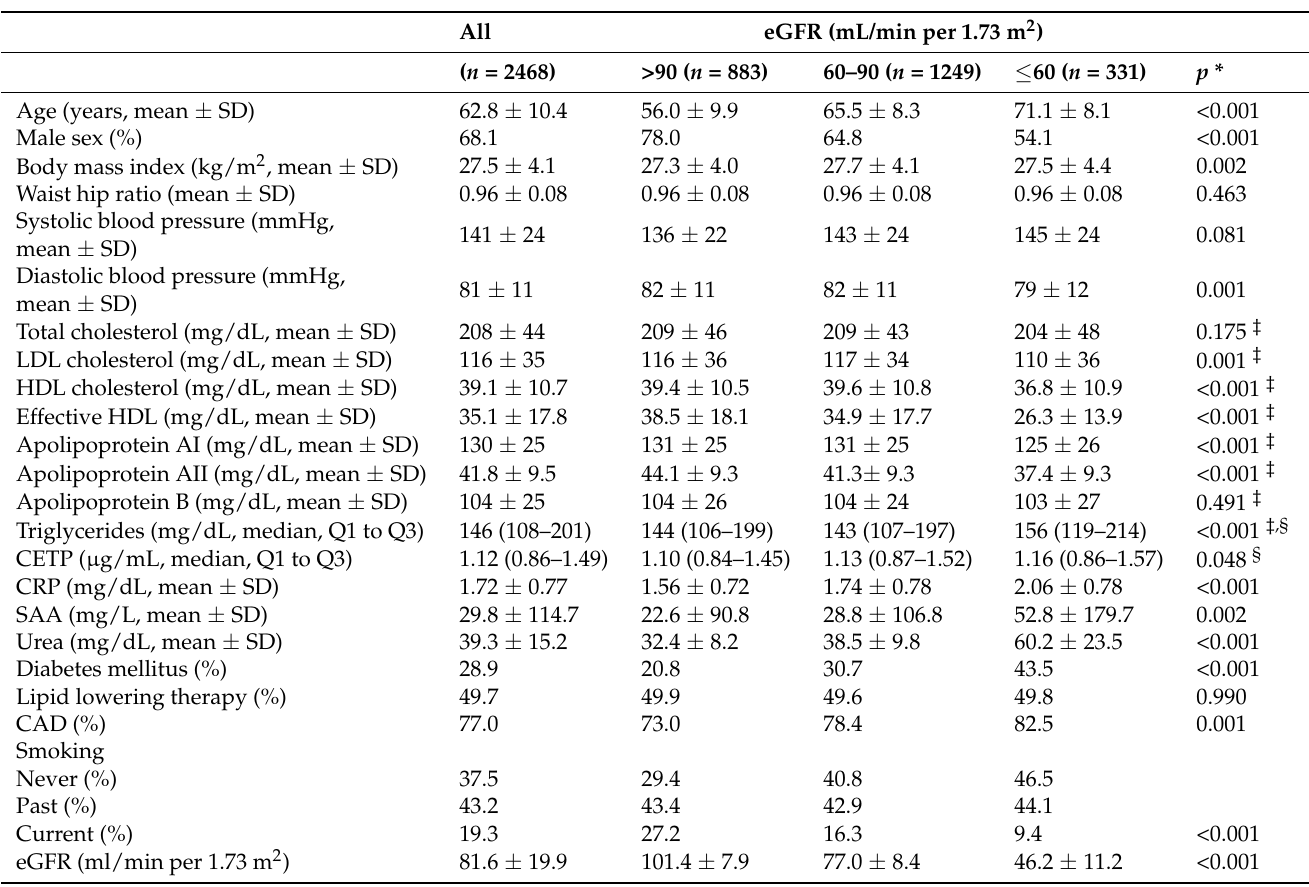
Table 1. Baseline characteristics of LURIC study